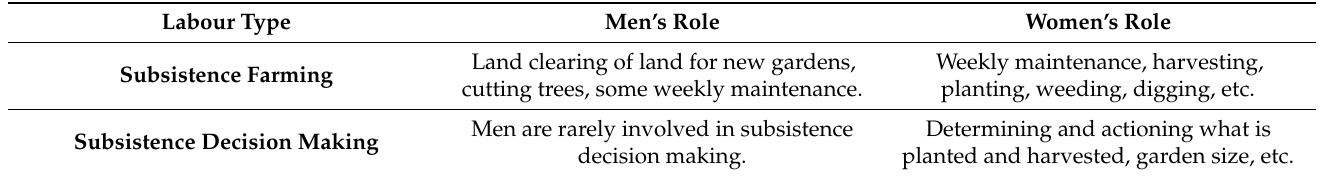
Weekly maintenance, harvesting, planting, weeding, digging, etc.